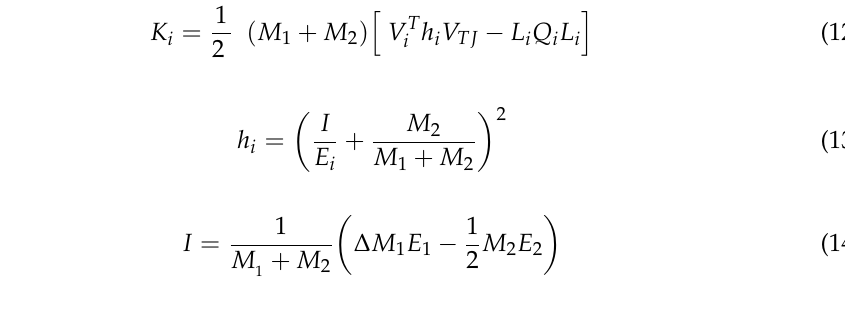
Figure 5. Schematic representation of a linear actuator as a manipulator’s leg. The machining bed consists of six kinematic chains, referred to as the machining bed legs. The leg of the machining bed consists of a linear actuator, universal joint, and ball and socket joint. The linear actuator consists of two parts: one is stationary and the other is movable. This movable part of the linear actuator produces different leg lengths. A description of the symbols can be found in the nomenclature section of this paper. The total kinetic energy of the leg can be written as given in Equation (12). The total potential energy of the leg is shown in Equation (16).